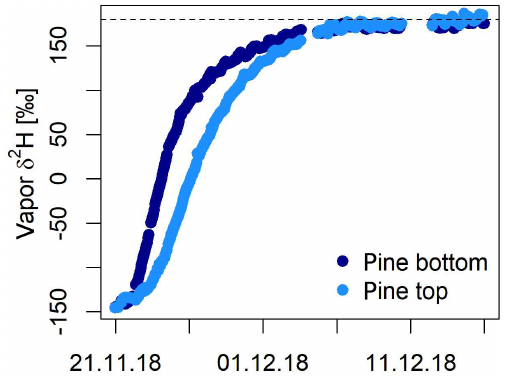
Figure 3. Xylem water δ 2 H values measured in the stem boreholes during a greenhouse experiment in Freiburg, Germany, on a pine tree (Marshall et al., 2020). Two boreholes were drilled through the stem, and their δ values were monitored over a period of 2 months. For both boreholes a close agreement of δ 2 H between source water and in situ data was